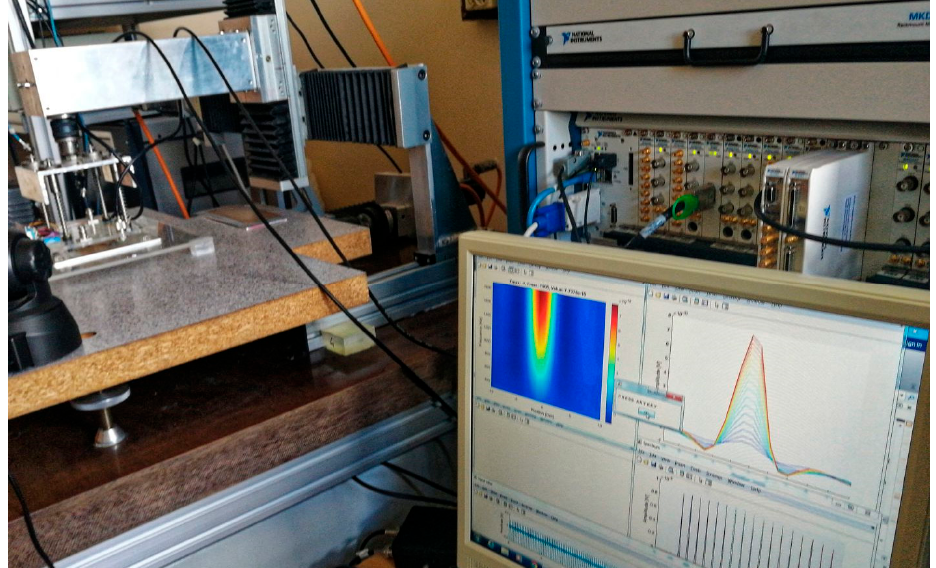
Figure 7. Photo of the experimental setup.